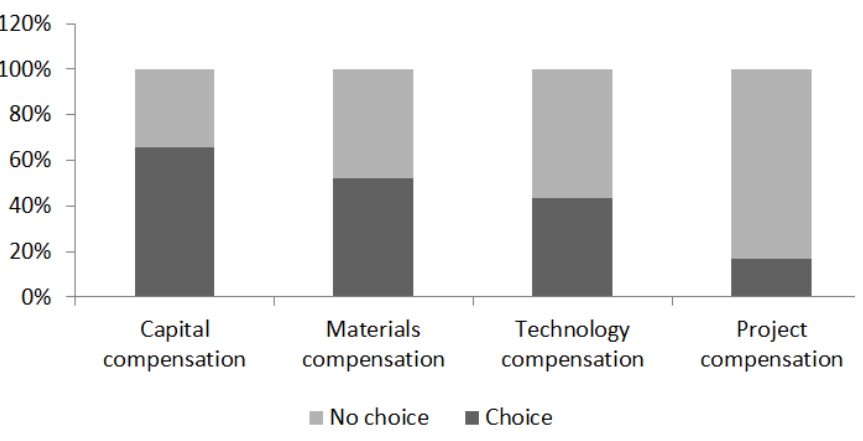
ff erent ecological compensation Figure 2. Farmers’ choice of four different ecological compensation methods. Figure 2. Farmers’ choice of four di